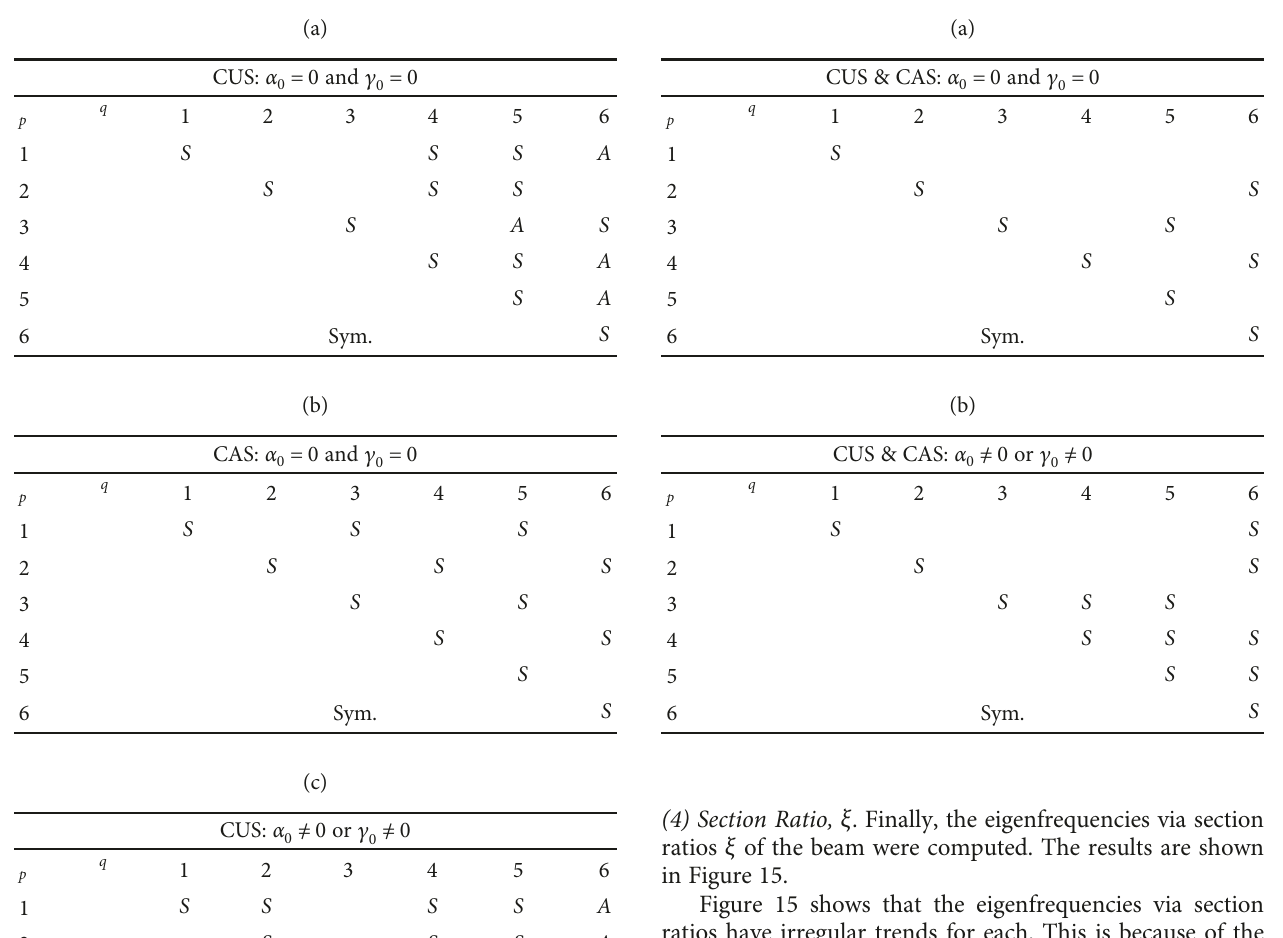
pq of Model A and Model